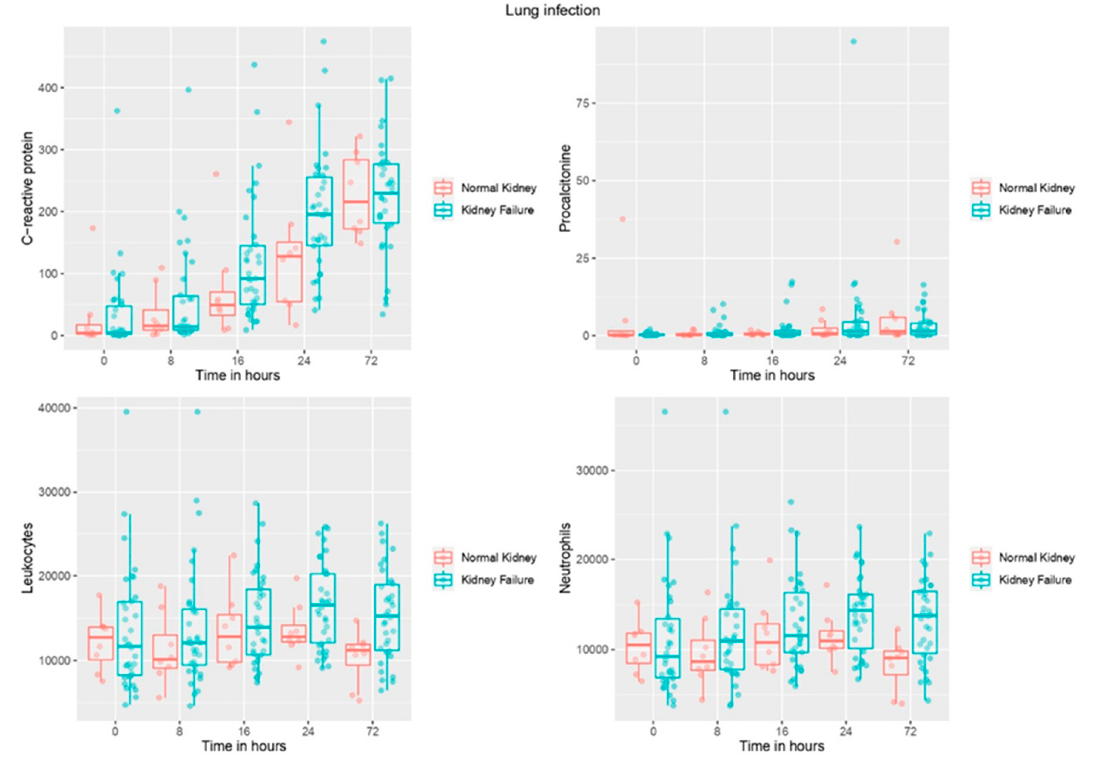
Figure 1. Box plots showing biomarker levels over time based on the presence/absence of renal failure in patients with infection.